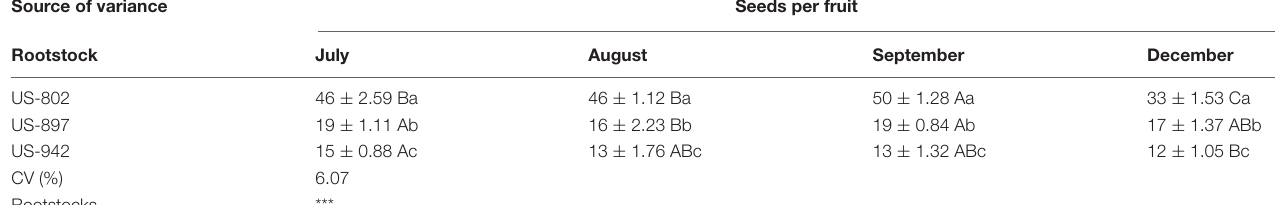
Source of variance Seeds per